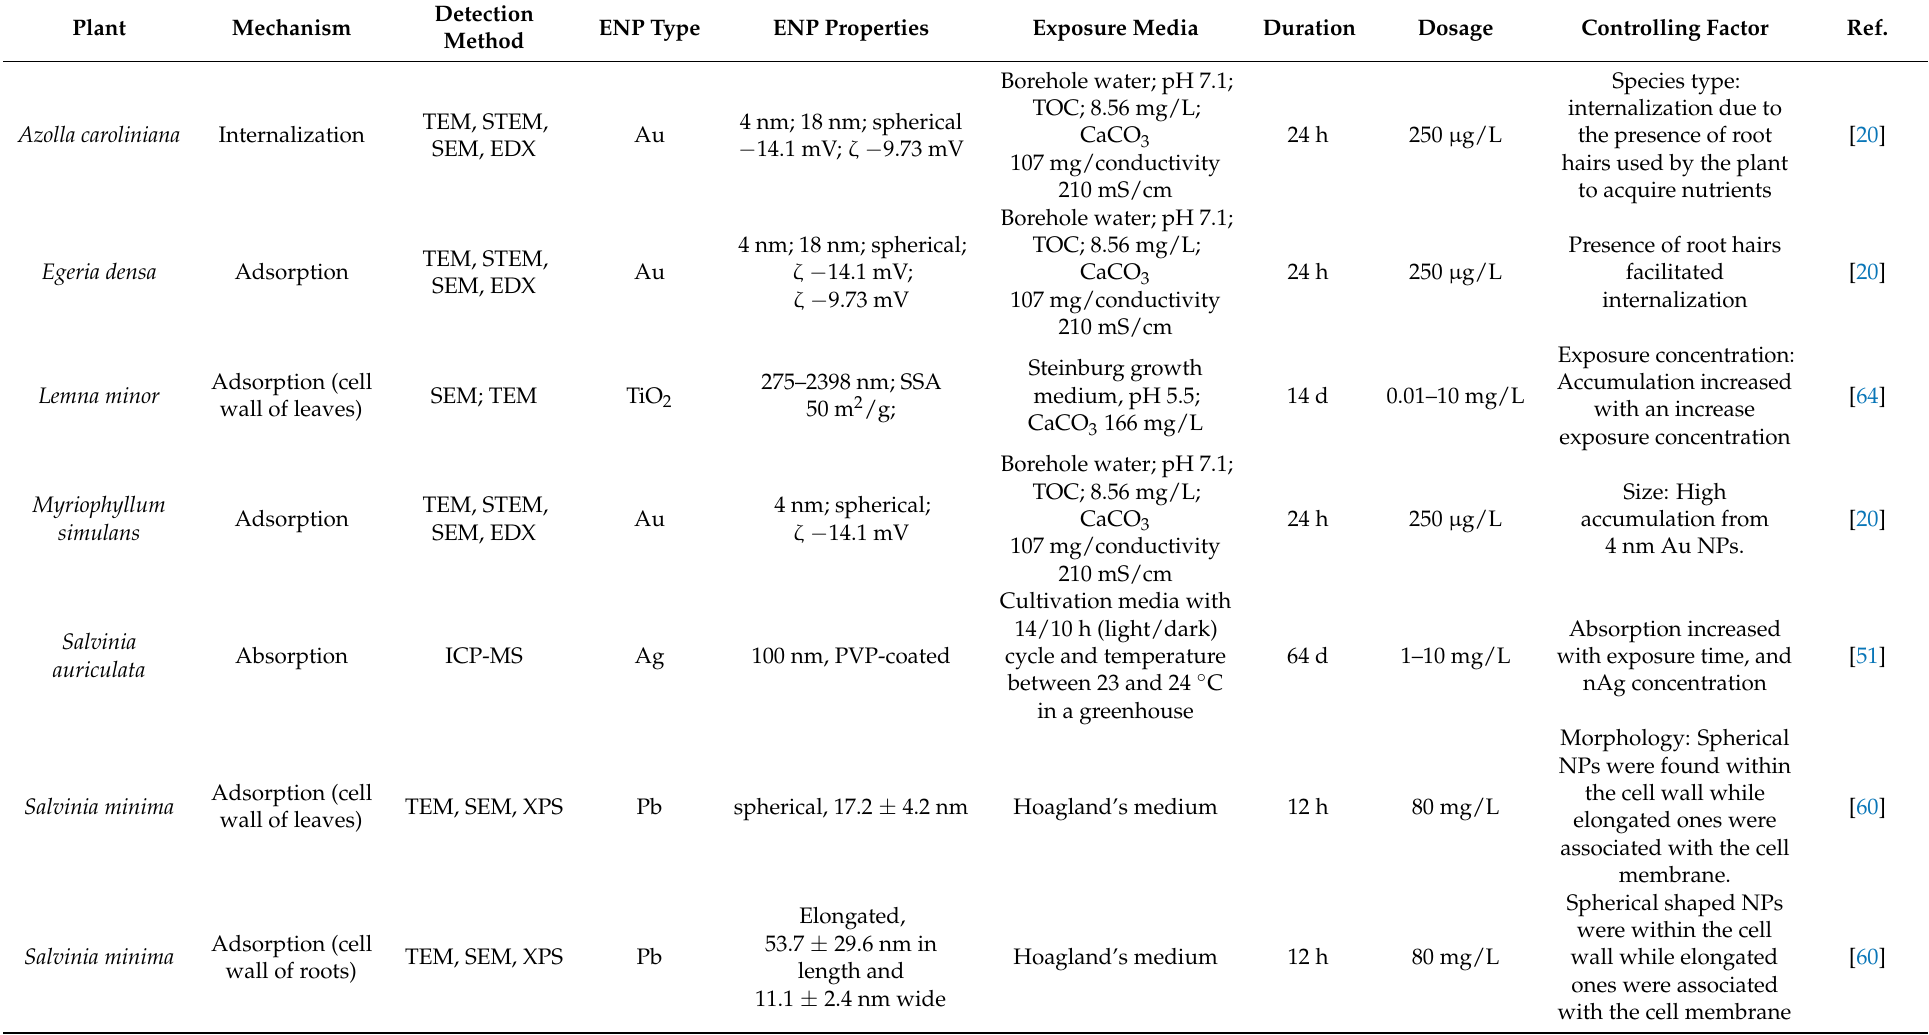
Table 1. Mechanisms of NPs accumulation by aquatic higher